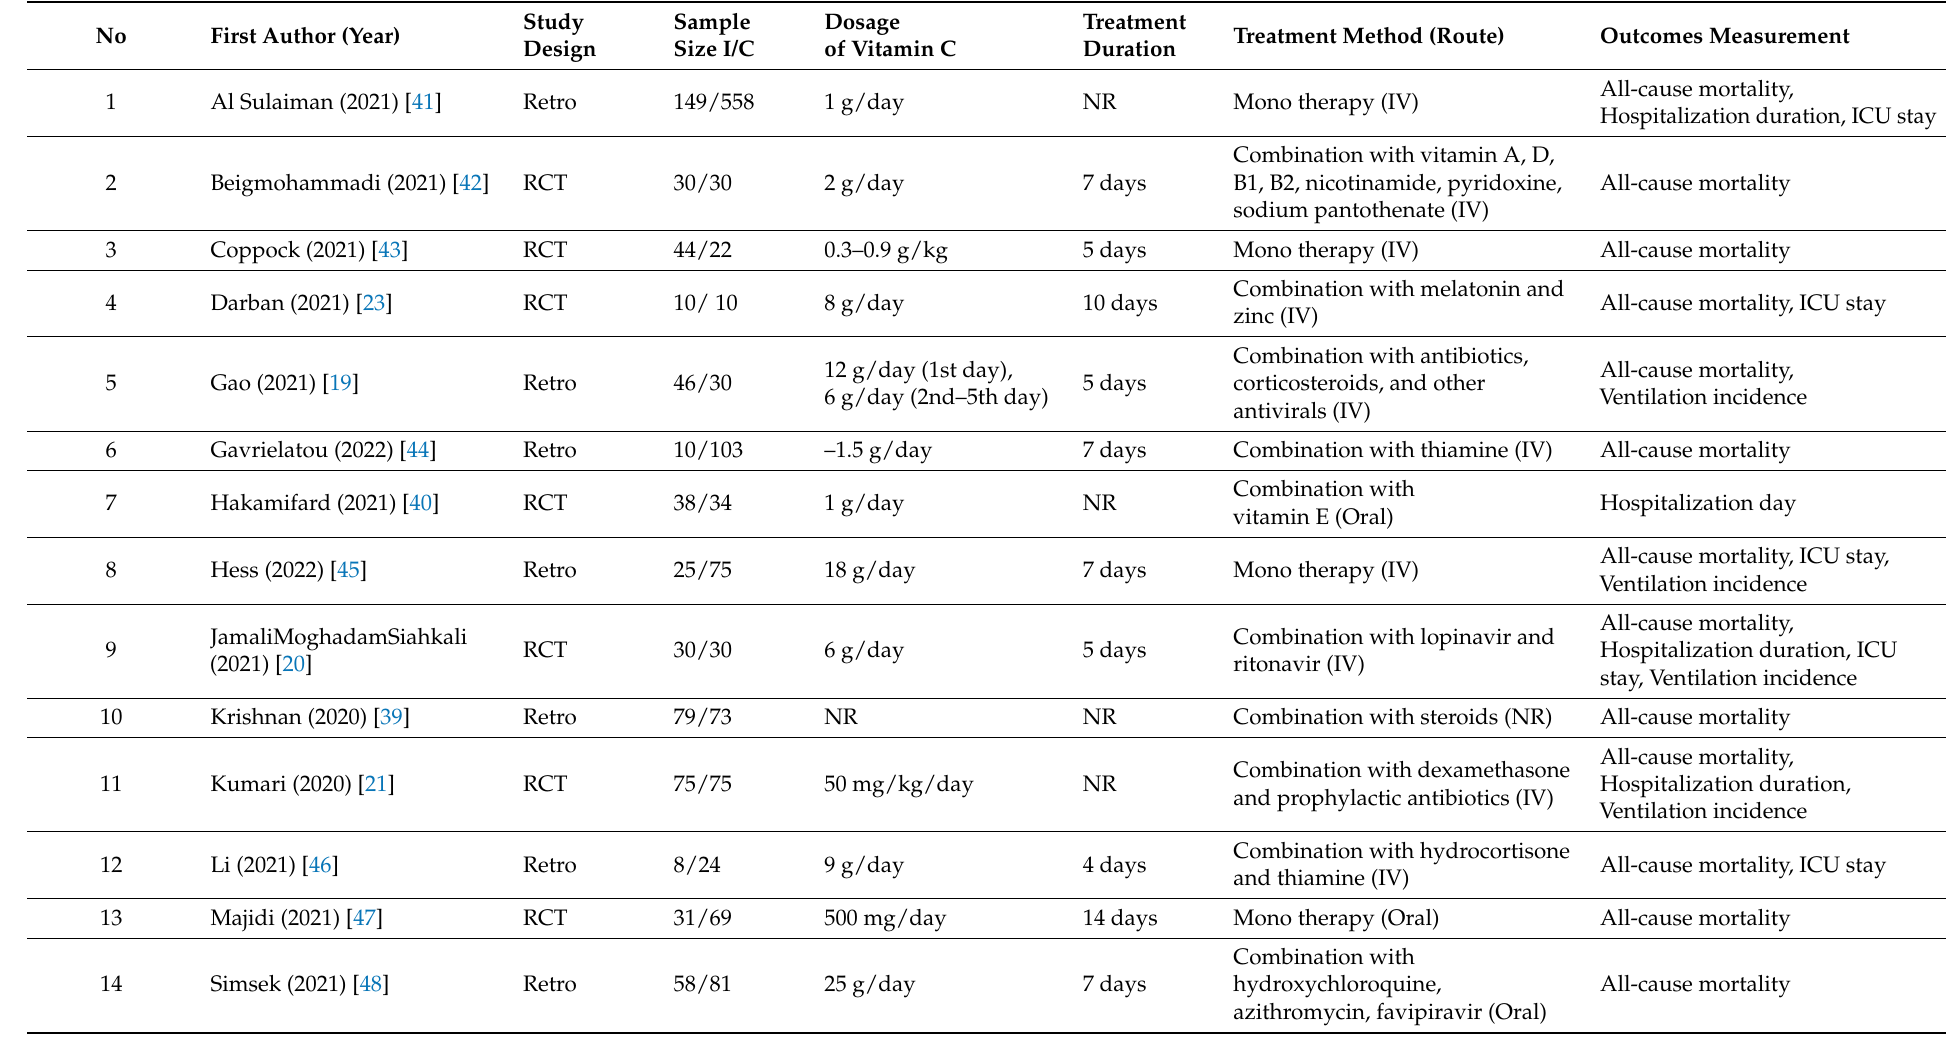
Table 1. Study characteristics of all included in